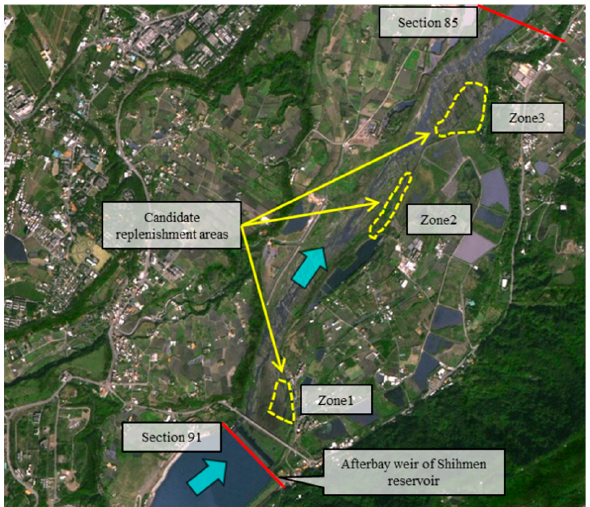
Figure 5. Candidate sediment replenishment areas.